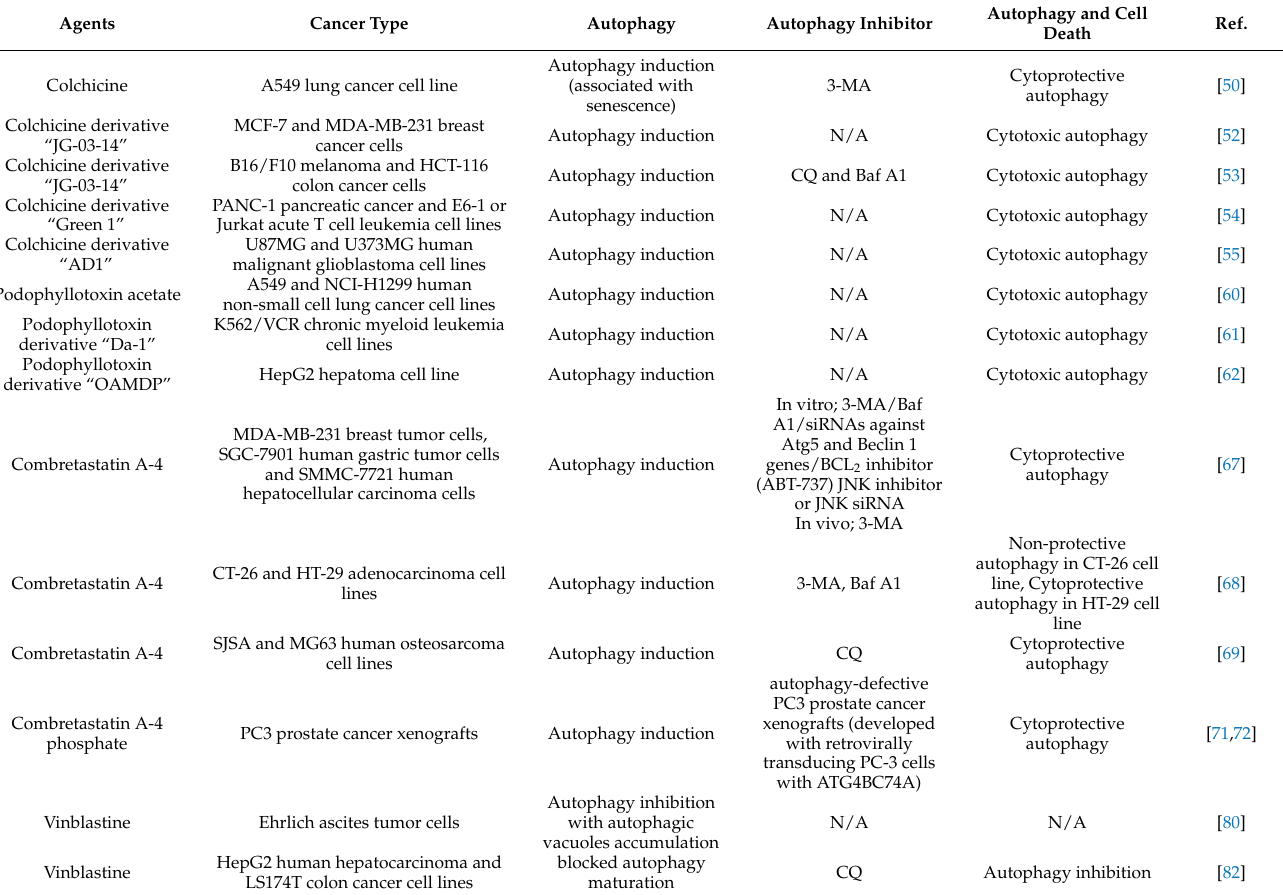
Table 1. Different autophagic forms induced by microtubule poisons in different cancer